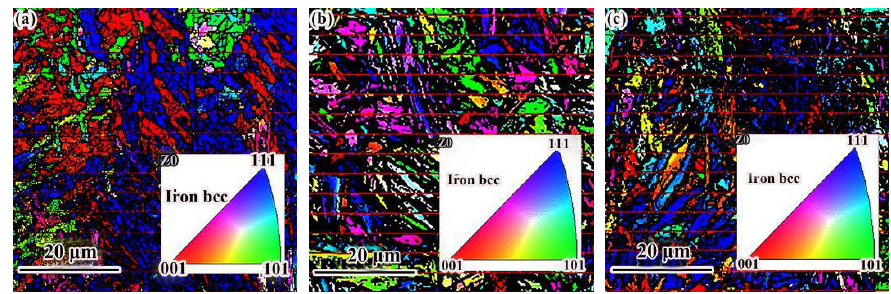
Figure 5. Grain size and grain boundary orientation: ( a ) as-deposited; ( b ) QT; ( c ) SR.